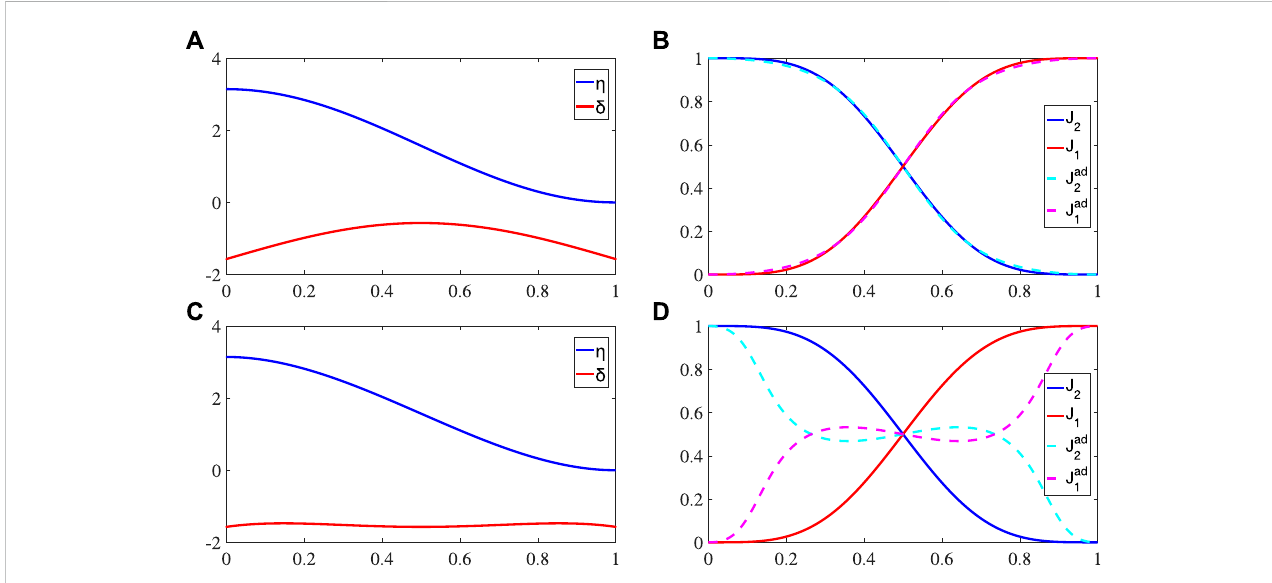
FIGURE 2 (A − C) Evolution oftheparameters η (solid blueline) and δ (solid red line). (B − D) Time evolution of theaction variables J 1 (solid red line), J 2 (solid blue line) driven by H d , and adiabatic approximate invariants J ad 1 (dashed red line) and J ad 2 (dashed blue line) when t / τ = 1 and τ =